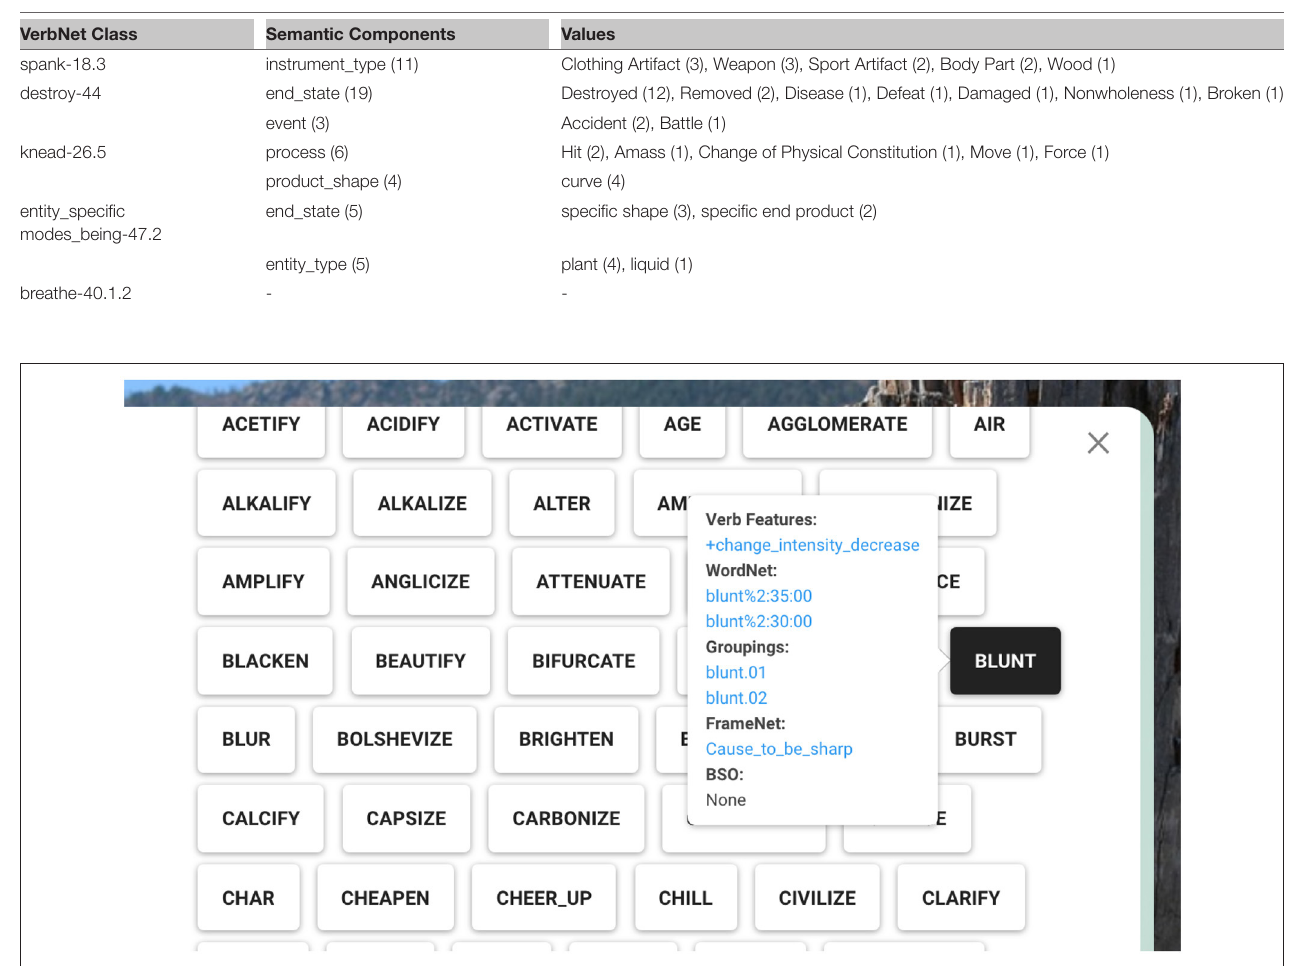
TABLE 6 | Five of the VerbNet classes having between 11 to 50 members.